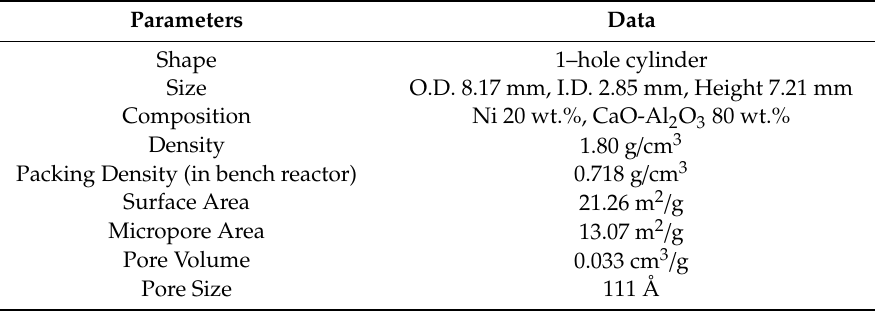
Table 4. Textural properties of the catalyst used